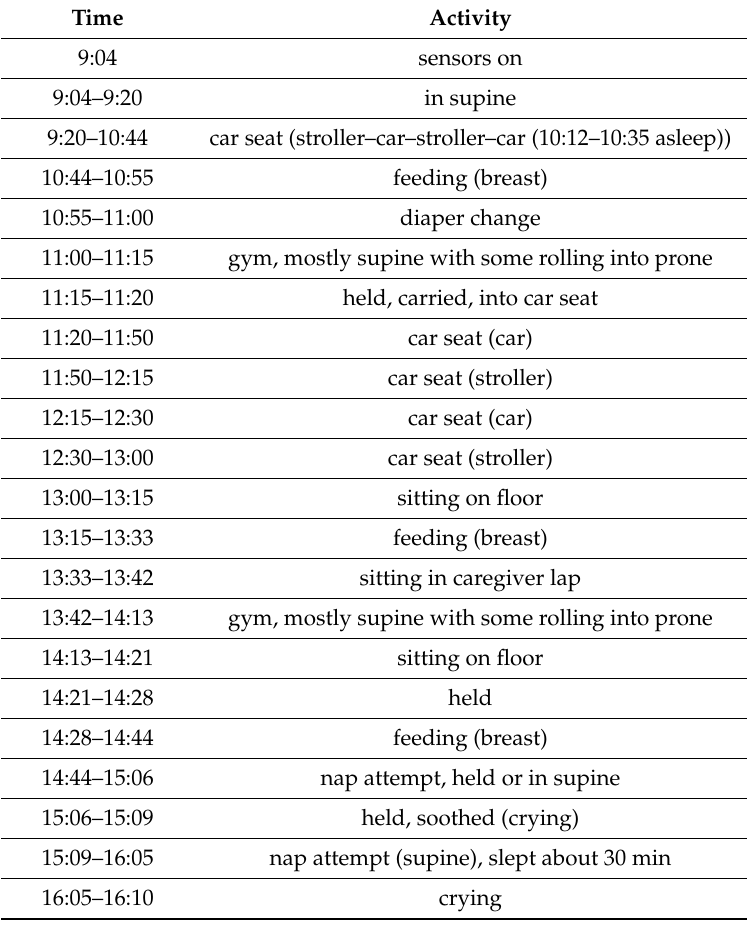
Table 3. Journal of infant activity across a full day in the natural environment. Time Activity 9:04 sensors